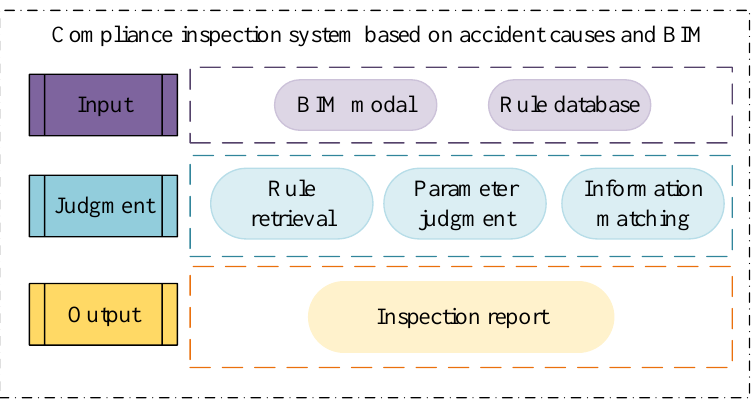
Figure 5. Overall system model diagram.